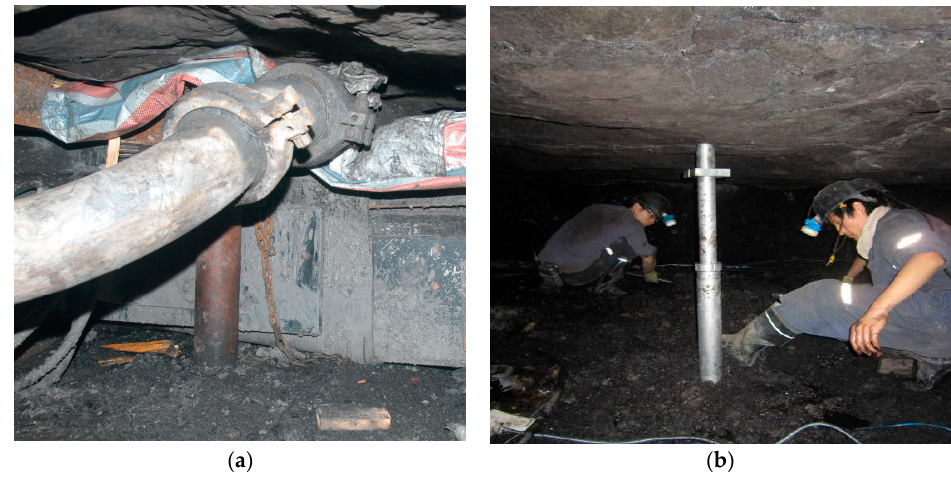
Figure 8. The original filling technology: ( a ) Preventing the overflow of the filling material ( b ) The limited activity and operating space.